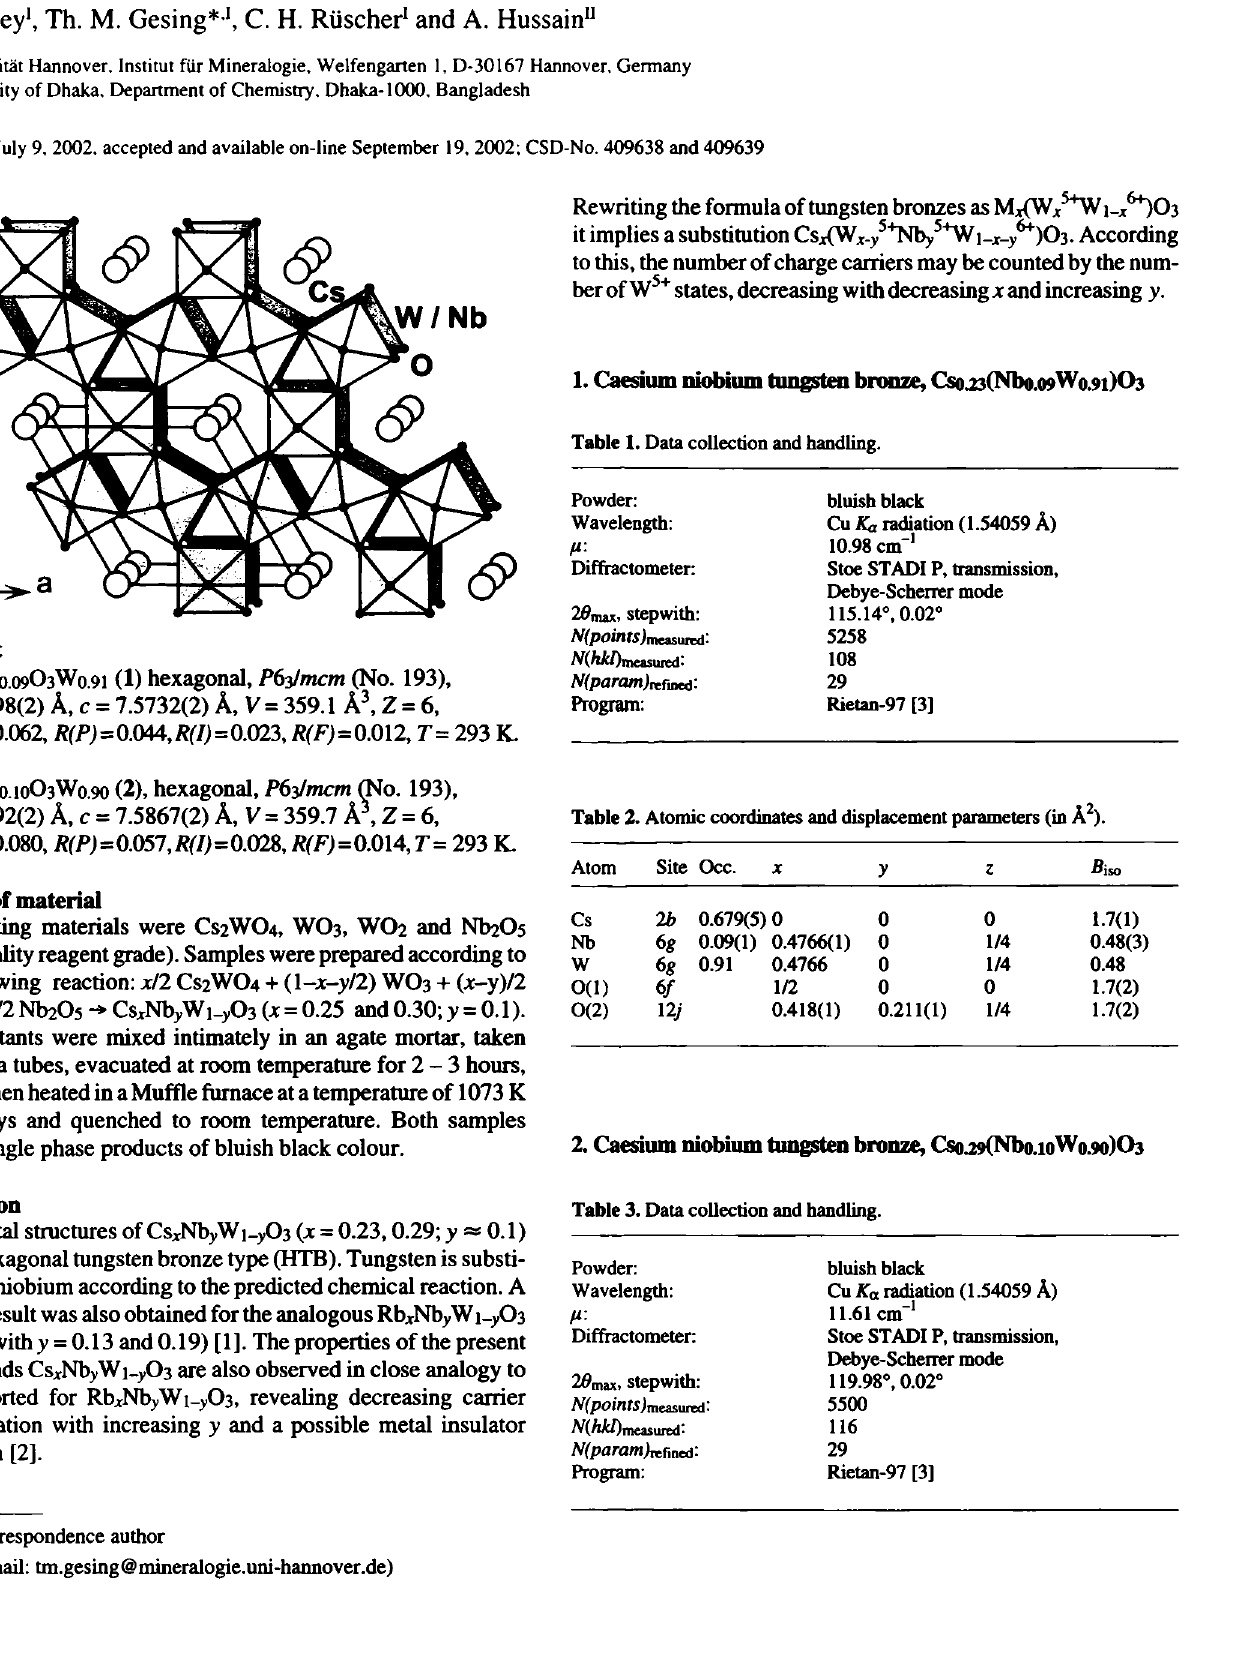
Table 3. Data collection and